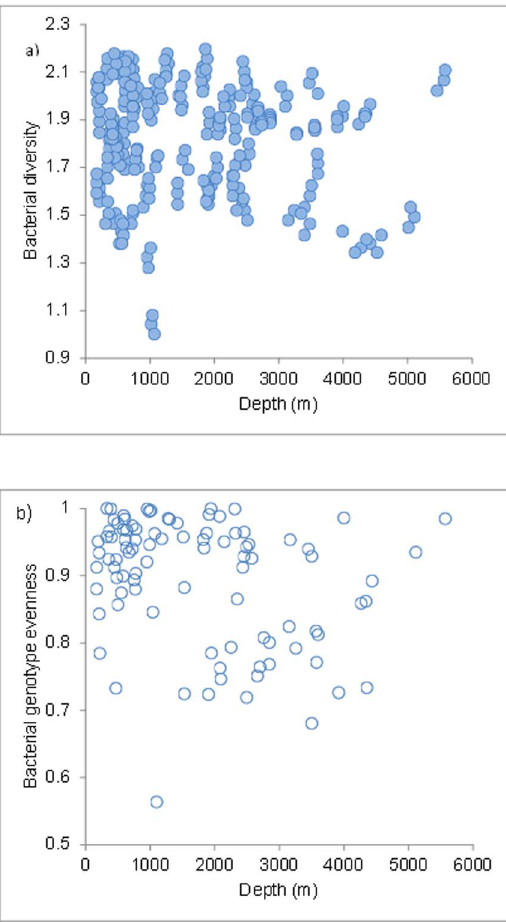
Figure 4. Spatial patterns of bacterial diversity as genotype richness. Reported are bathymetric gradients of A) bacterial diversity and B) Bacterial Evenness (ARISA). Data are from the Arctic (n=42), North Atlantic (n=33), central Atlantic (n=100) and Mediterranean Sea (n=113) (Sources = HERMIONE project and the Pangea database). doi:10.1371/journal.pone.0058909.g004 Figure 5. Spatial patterns of meiofaunal and macrofaunal